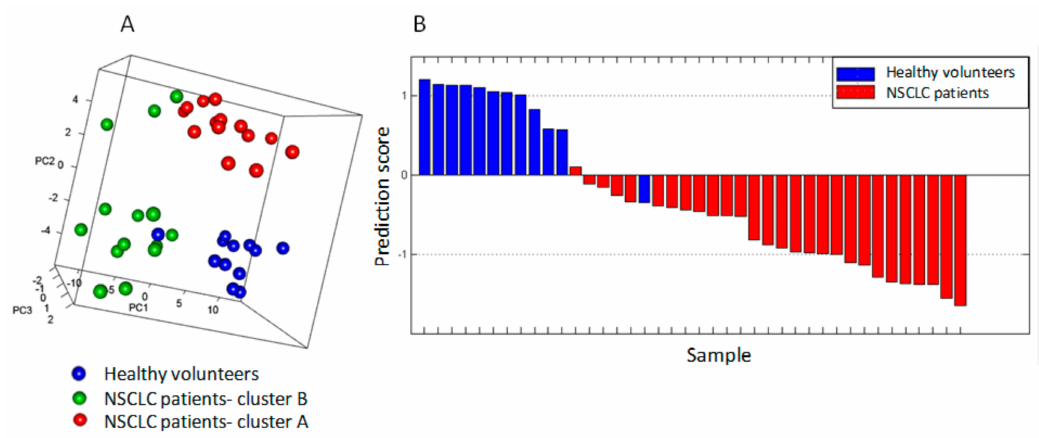
Figure 2. Prediction of PBMC source based on basal serine / threonine kinase (STK) activity profiles. ( A ) The 3D plot, obtained after applying unsupervised principal component analysis (PCA), separates samples in three groups. Each label represents a PBMC sample from 12 healthy volunteers (blue) or non-small-cell lung cancer (NSCLC) patients: 14 from cluster A (red) and 14 from cluster B (green). All volunteers, except one, remain in the same group. ( B ) Partial least squares discriminant analysis classifies healthy volunteers (blue) and patients (red) PBMC. Samples prediction scores were obtained based on a leave-one-out cross-validation. Samples with a positive score correspond to predicted healthy volunteers whereas samples with a negative score correspond to predicted NSCLC